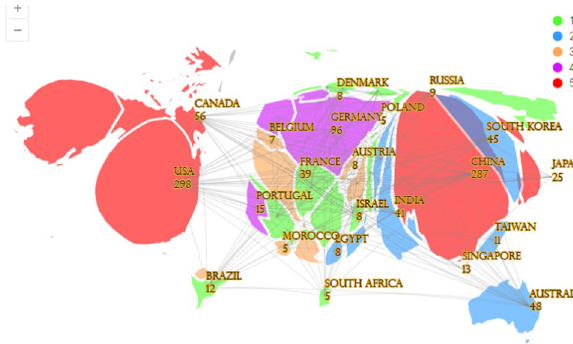
Fig. 5 Author distribution by